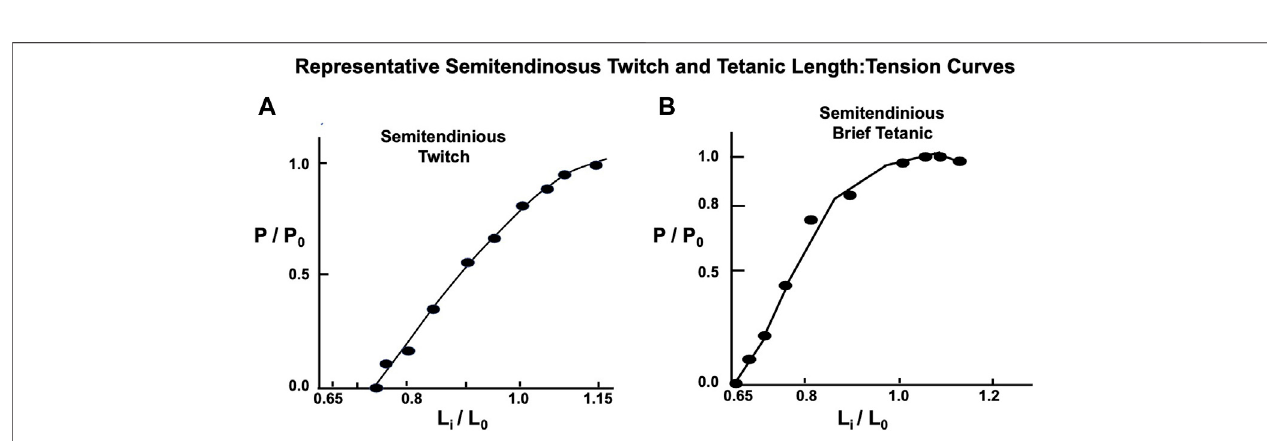
FIGURE7| RepresentativesemitendinosusLength:Tensioncurveswithbothtwitchandbrieftetaniccontractions.Notein (A) L i islocatedatalongerlengthasthe L i in (B) for the brief tetanic contractions, and the twitch curve does not fl atten as the muscle is stretched to L 0 and beyond, as is the case with the classic curve seen in Figure 1B and the brief tetanic length:tension curve from the same muscle in (B) .